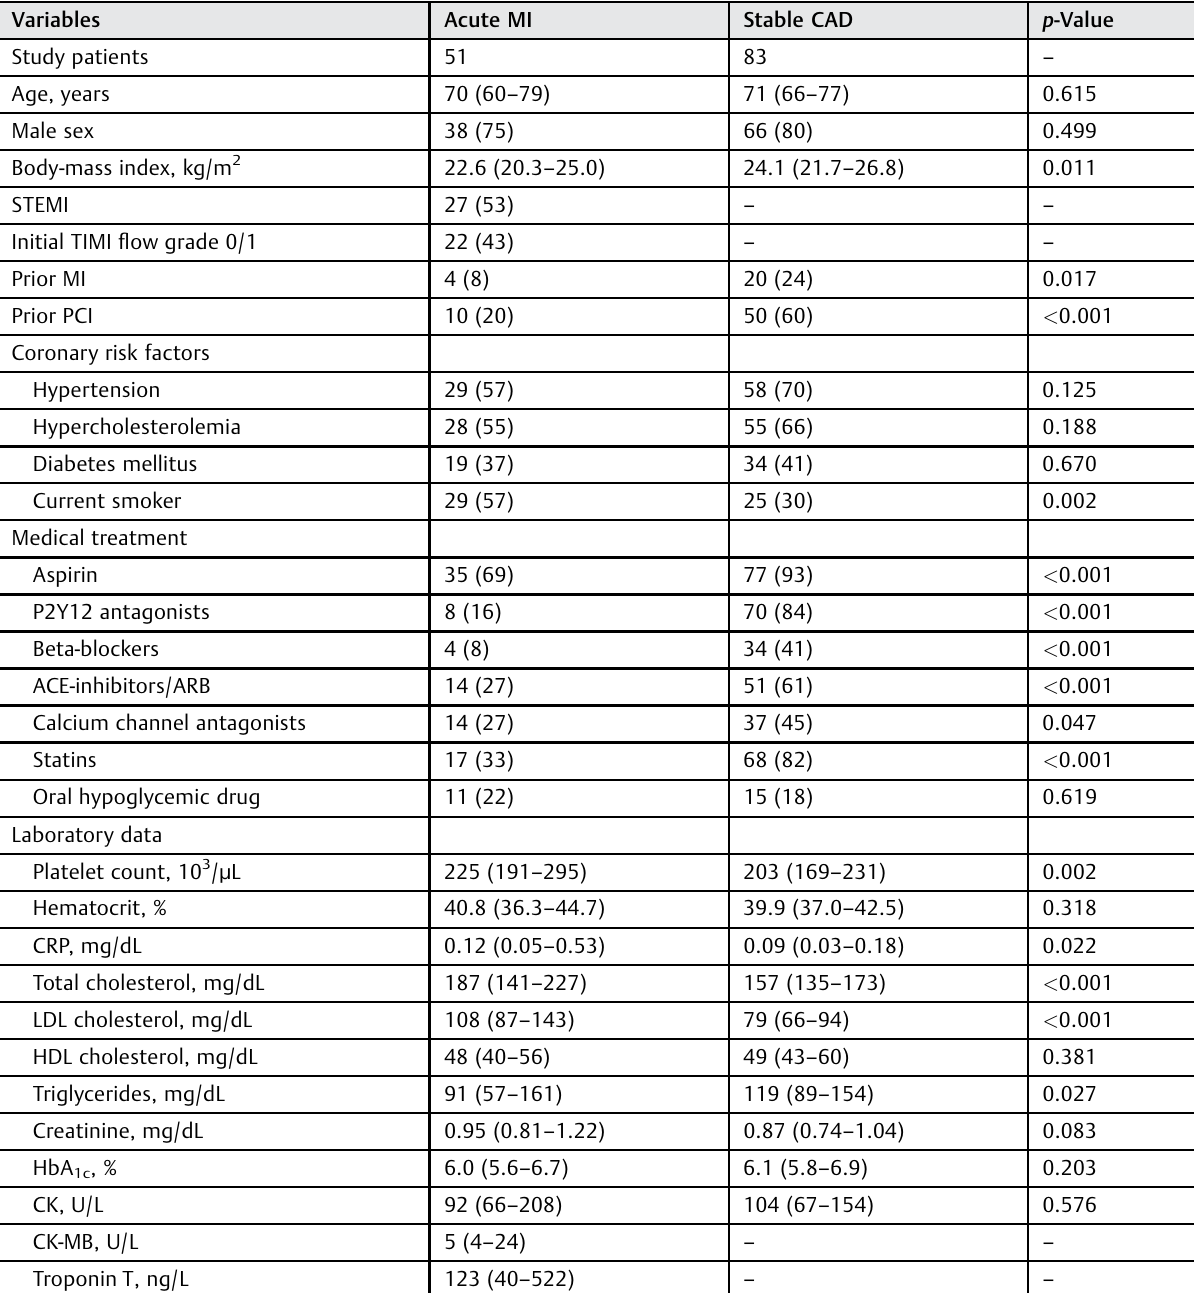
Table 1 Baseline characteristics of patients with acute MI or stable CAD Variables Acute MI Stable